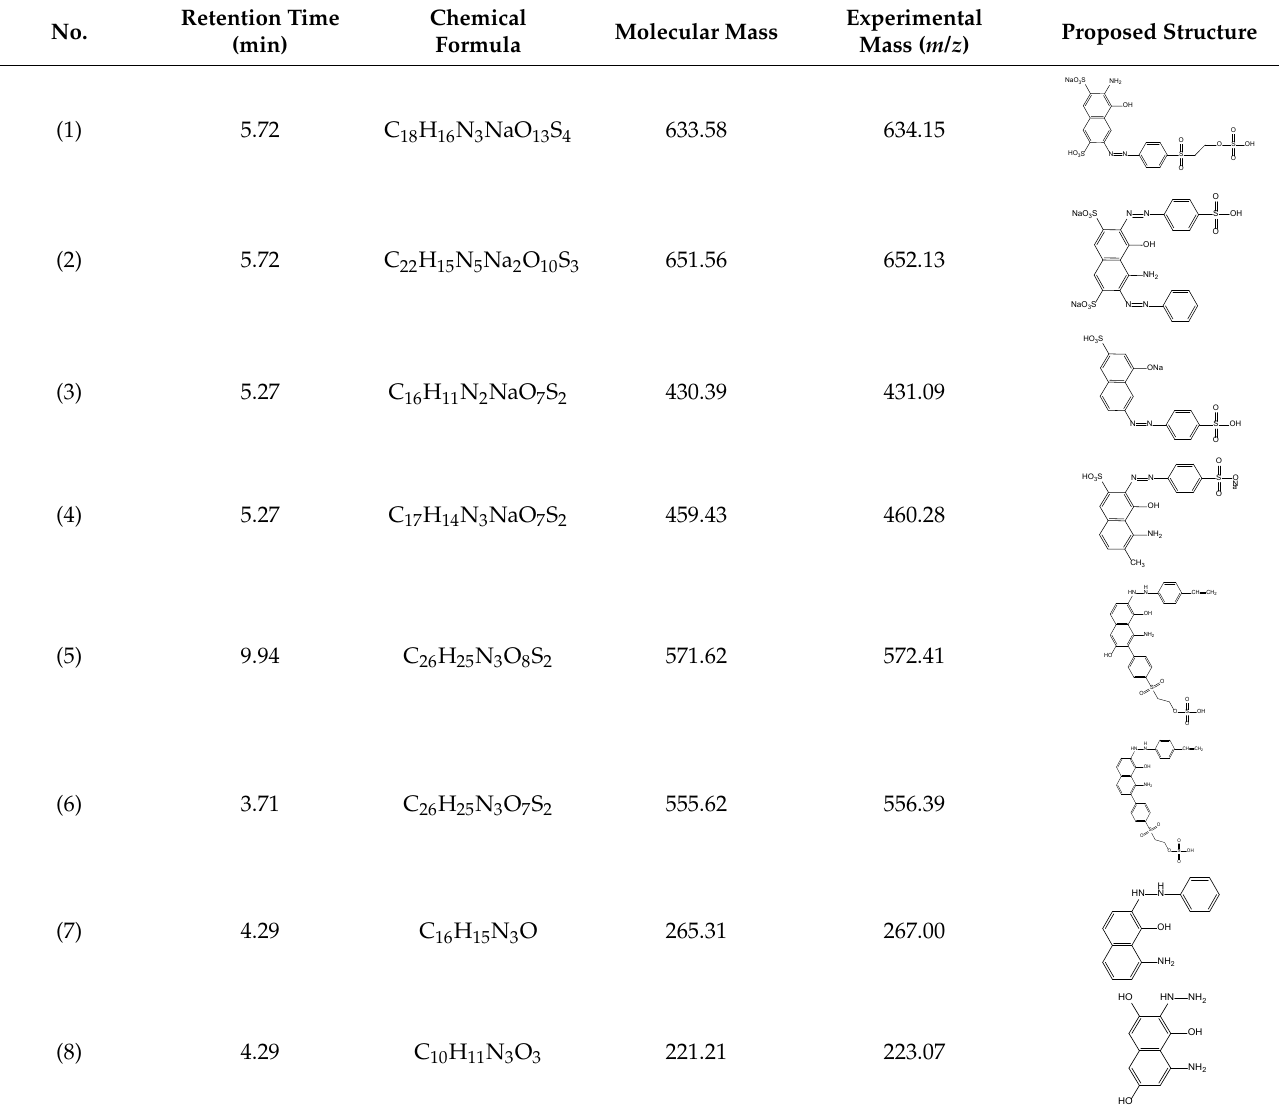
Table 2. Details and proposed molecular structure of detected degradation intermediates during Fe 2+ /PAA/H 2 O 2 oxidation of RB5.